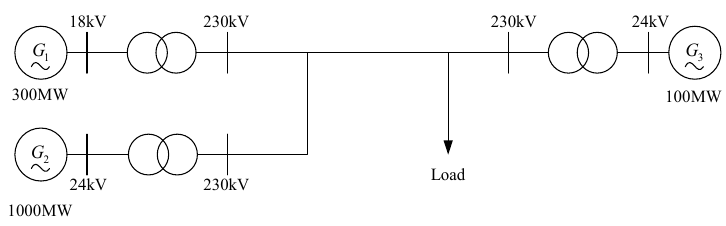
Figure 28. Structure of the system example.